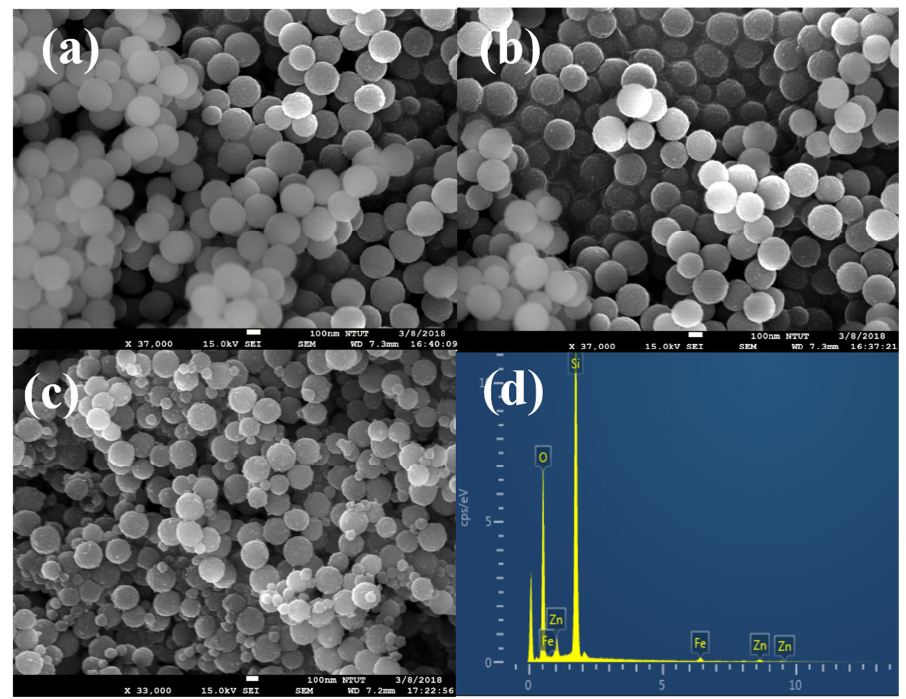
Figure 2. FESEM images of ( a ) SiO 2 @ZnO, ( b ) SiO 2 @α-Fe 2 O 3 and ( c ) SiO 2 @α-Fe 2 O 3 /ZnO nanocomposites. ( d ) Energy dispersive X-ray spectroscopy (EDX) analysis of SiO 2 @α-Fe 2 O 3 /ZnO nanocomposites.